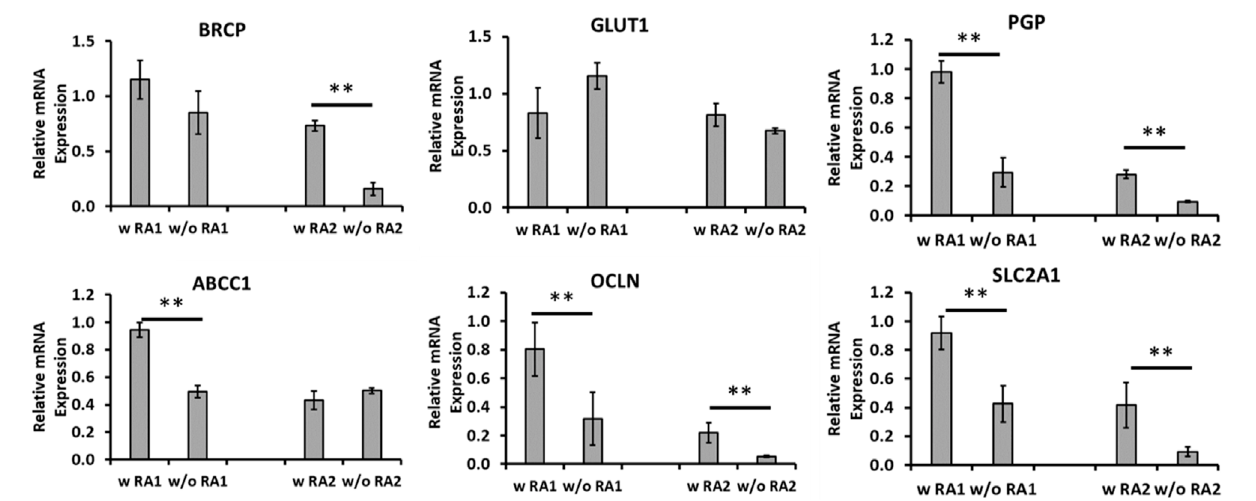
FIGURE 4 | mRNA levels for blood – brain barrier (BBB) markers comparing endothelial cells (iECs) derived with and without retinoic acid (RA). mRNA expression wasdeterminedbyRT-PCRforendothelialcellsderivedwithRAcomparedtothosewithoutRAtreatmentinduplicatedifferentiations.mRNAexpressionwasnormalized to the non-RA – treated endothelial cells. Common BBB markers were chosen for comparison, including BRCP , GLUT-1 , PGP , and ABCC1 encoding multidrug resistance-associated protein 1 (MRP1), OCLN , and SLC2A1 (different primer pair from GLUT-1 ). N = 3. The RT-PCR results were expressed as the mean ± standard deviation. ** indicates p < 0.05 for the compared